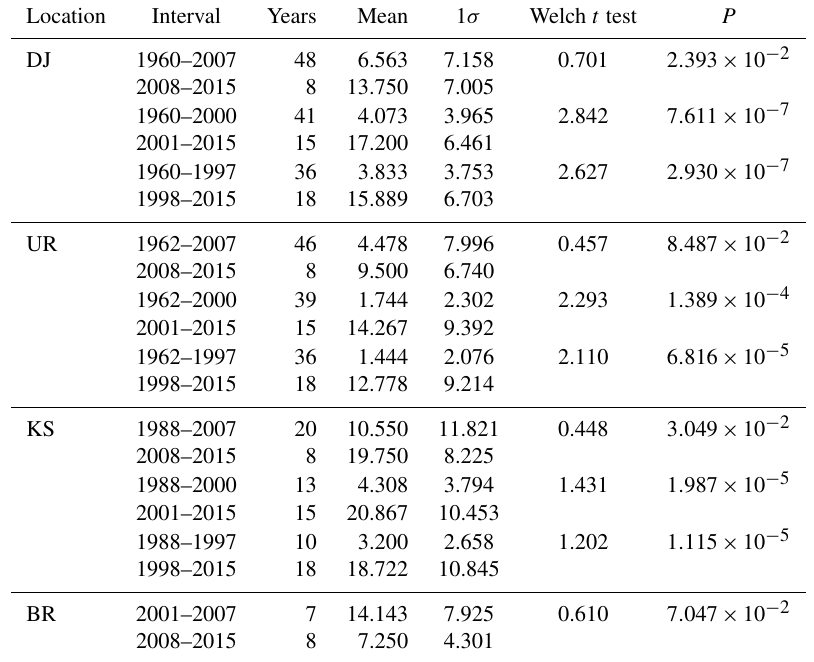
Table 3. Statistical significance of the increased occurrence rate of ADS events.